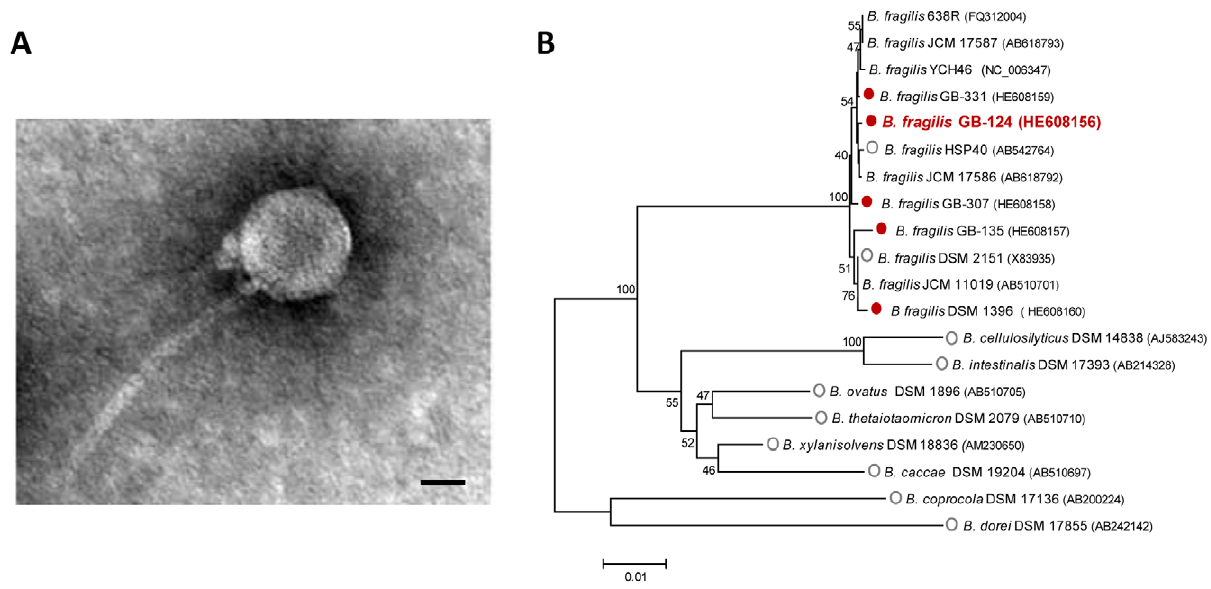
Figure 1. Physical structure and host range of W B124-14. A. Transmission electron micrograph of W B124-14 showing phage capsid composed of an icosahedral head and a non-contractile tail. Magnification 50,000 6 . Scale Bar, 20 nm. B. Phylogenetic characterisation of B. fragilis w B124-14 host strains. Consensus maximum likelihood trees were constructed from 16S rRNA gene sequences, with 1000 bootstrap resamplings using MEGA v5. Bootstrap values of 40 or greater are shown adjacent to respective nodes. Accession numbers for bacterial 16S sequences are given in brackets following species names on the tree. The ability of w B124-14 to replicate in a particular host species was tested in standard agar overlay assays, in which replication of w B124-14 in a particular host was indicated by production of plaques in bacterial lawns. Species tested in host range assays are denoted by open or filled circles. Filled red circles indicate strains which support w B124-14 replication, and open grey circles indicate strains in which w B124 did not